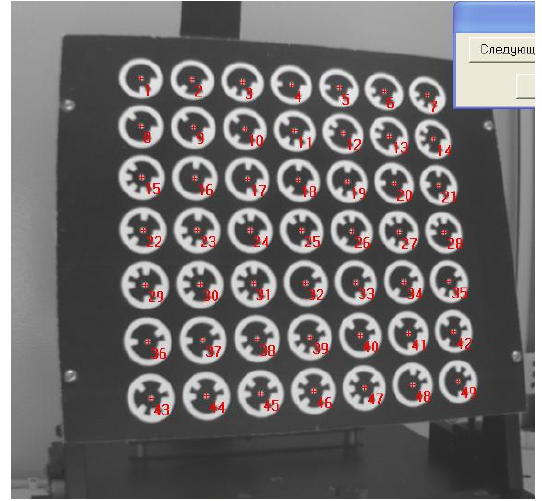
Figure 3. Rotation stage with test field for calibration